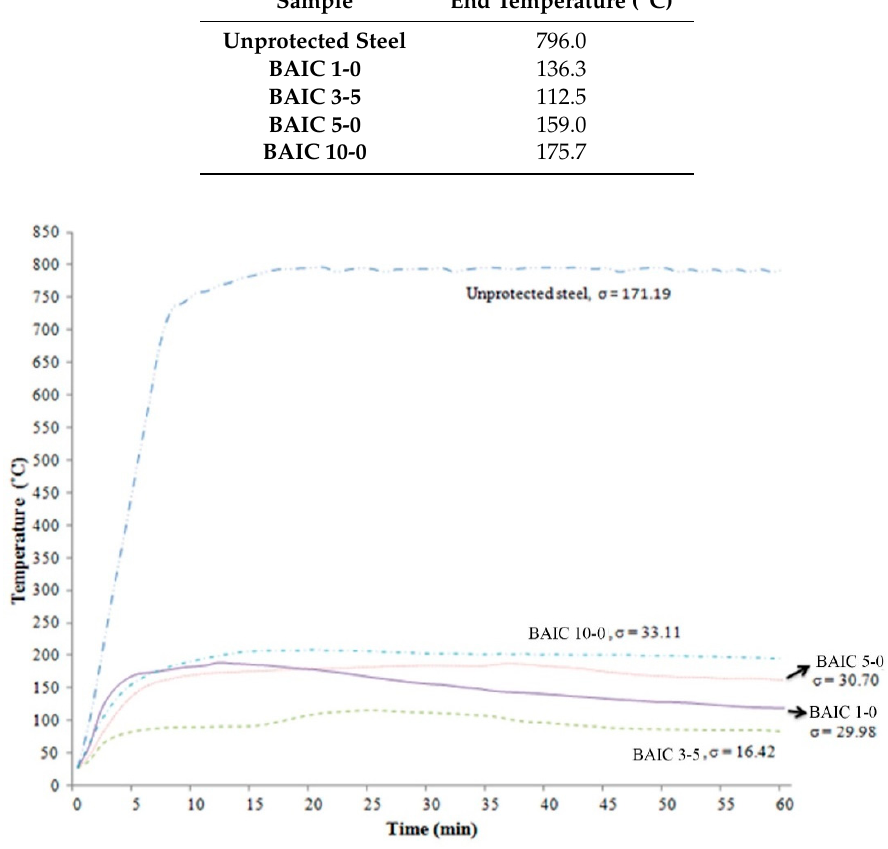
Figure 2. Temperature profiles and standard deviations of unprotected and protected steels with BAIC samples after a one-hour fire resistance test.